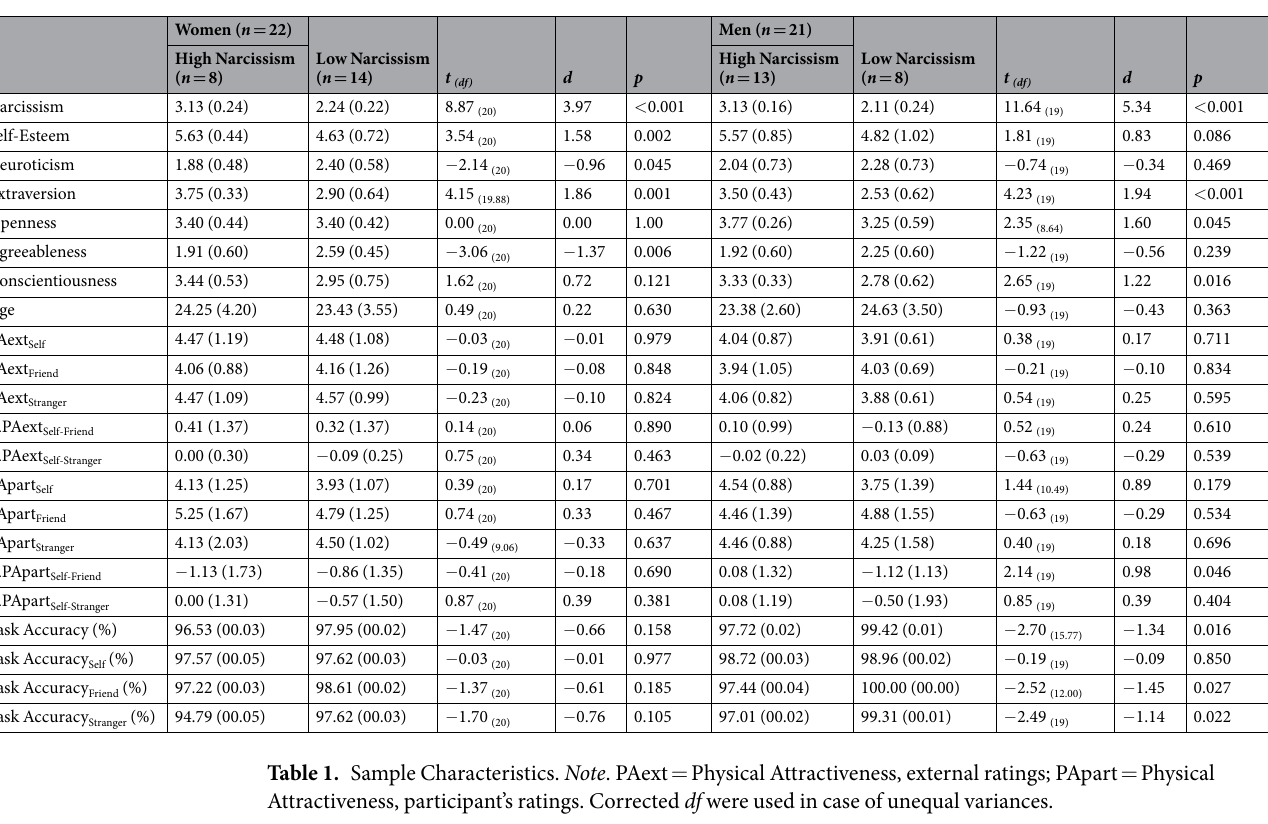
vertical angles under standardized lighting conditions. Figure 1 shows a sample photo. Photographs were rated for physical attractiveness by six independent raters ( α = 0.88). The independent ratings did not show significant differences between Self and Friend or Self and Stranger photographs (PA Self = 4.24 [0.97], PA Friend = 4.05 [1.01], PA Stranger = 4.27 [0.92]; t 42 Self-Friend = 1.06, d = 0.19, p = 0.297; t 42 Self-Stanger = − 0.84, d = − 0.03, p = 0.404). Table 1 provides sex-split external PA ratings and group comparisons within sexes; there were no significant differences between narcissism groups. At the second lab session, participants underwent the fMRI experiment. After initial instruction outside the scanner, the fMRI session consisted of three blocks encompassing 36 trials each in which participants were pre- sented twelve Self , Friend , and Stranger photographs (with the latter being matched for physical attractiveness) in different horizontal and vertical angles. Conditions were randomized within each block. Blocks were separated by resting periods of 20 sec. The total duration of the MRI experiment was about 10 min. Figure 1 depicts the time course of a single trial, which consisted of a fixation period (jittered to an average of two seconds within subjects), followed by a one-second presentation of a photograph ( Self / Friend / Stranger ), and a two-seconds response period, in which participants were asked to indicate via button press whether the face was oriented left or right. This task was chosen to ensure that participants’ attention was directed to the experimental